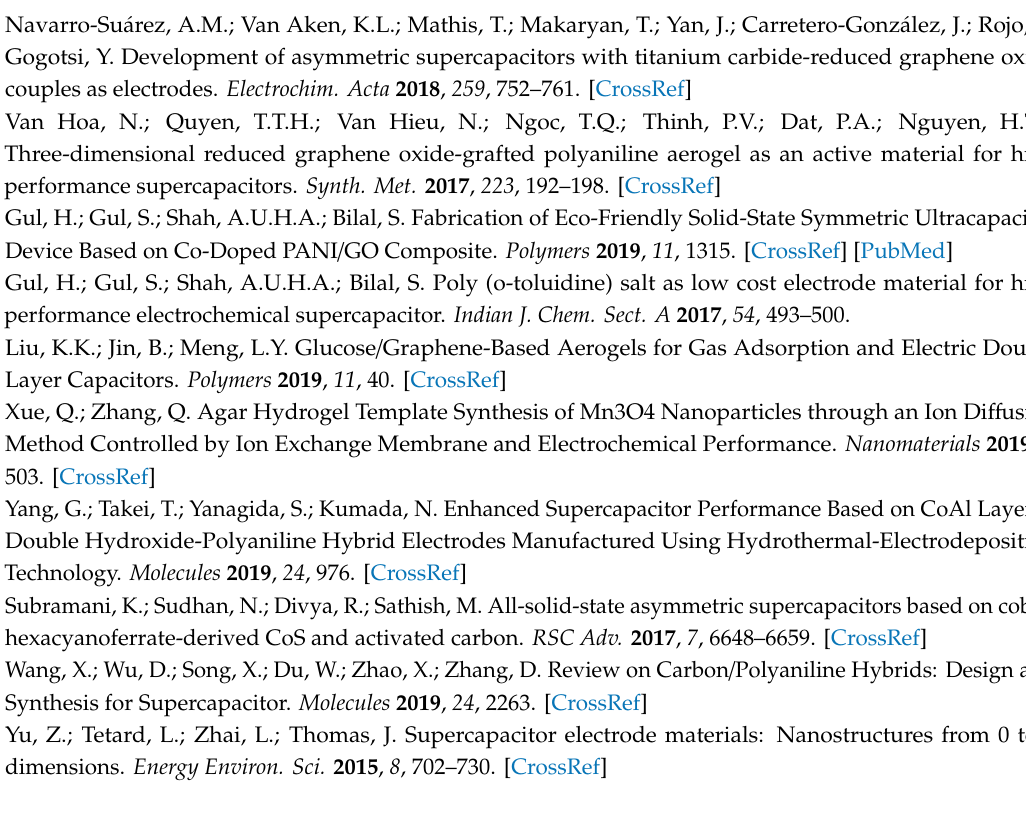
Figure S1: CV of PANI and GO@PANI nanocomposite in three electrode setups. Figure S2: CV of AC and GO@PANI nanocomposite in three electrode